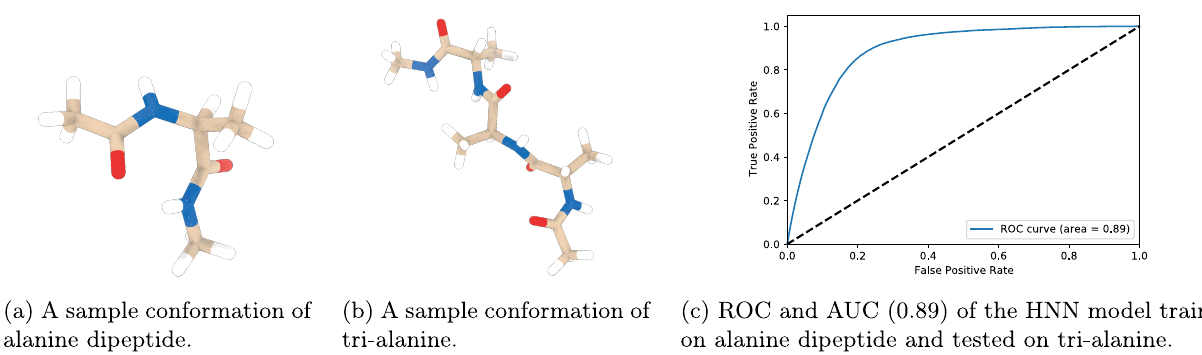
Fig. 3 Molecules used in training and testing of the HNN model, along with its ROC and AUC. Alanine dipeptide ( A ) was used in training the system, tri- alanine ( B ) was used in testing the system, and the resulting ROC and AUC ( C ).